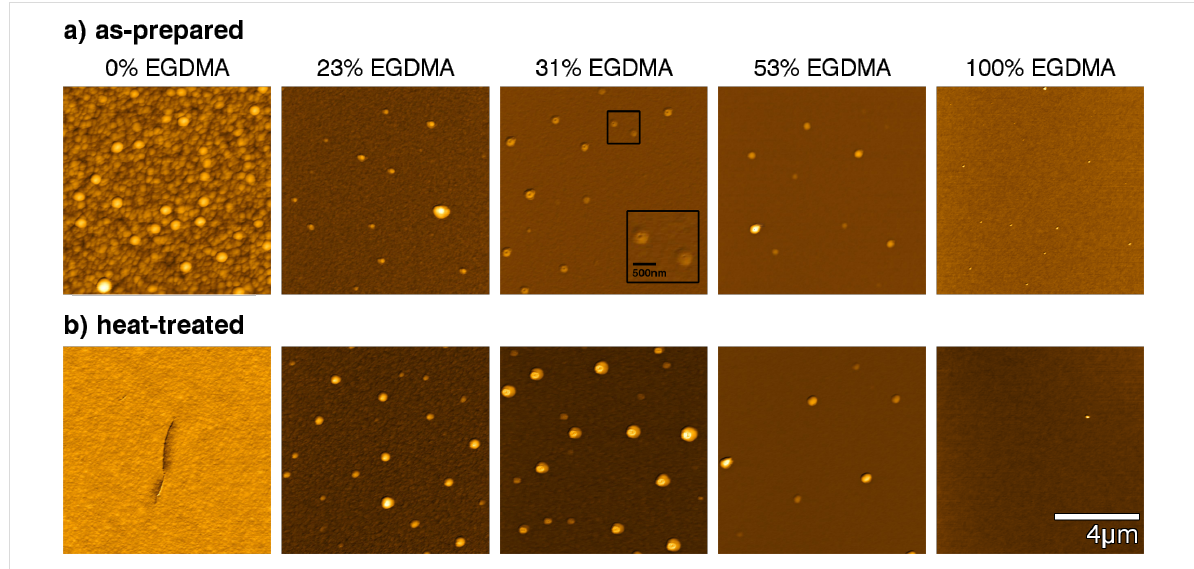
Figure 3: AFM height micrographs of as-prepared (a) and heat-treated (b) p-PFDA films with different degrees of EGDMA cross-linking. The data are represented on individual color scales for clarity.